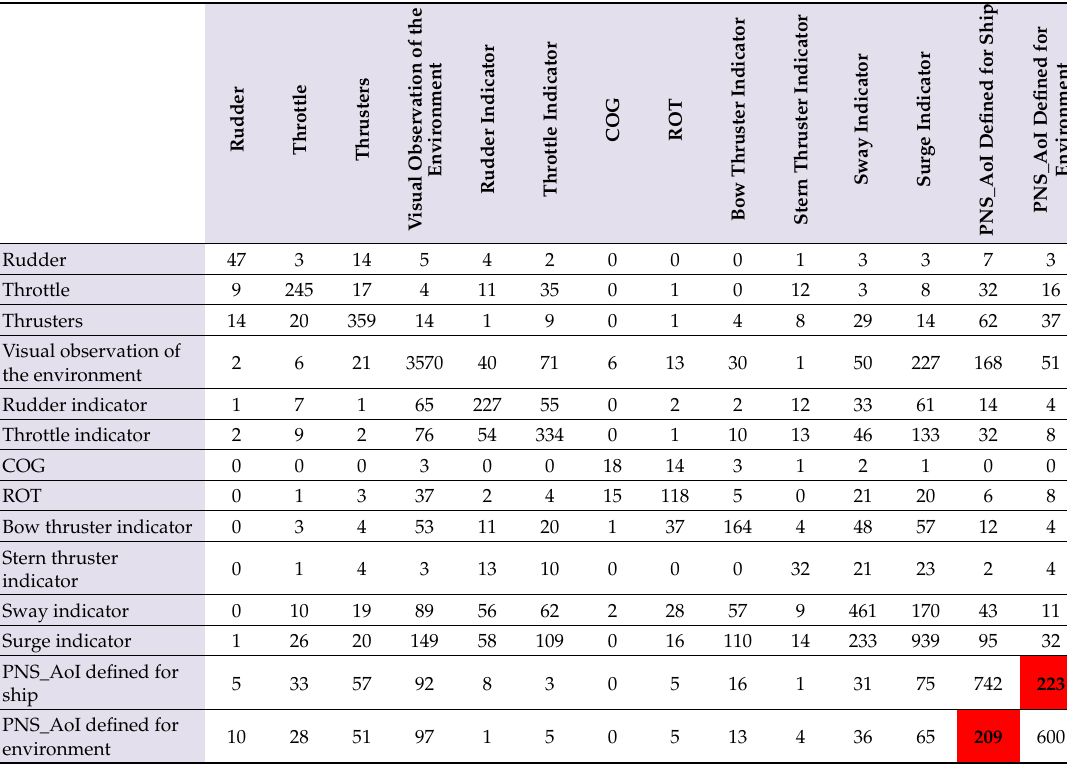
Table 1. The number of fixations for mooring, turning, and fairway passage in the areas of interest.